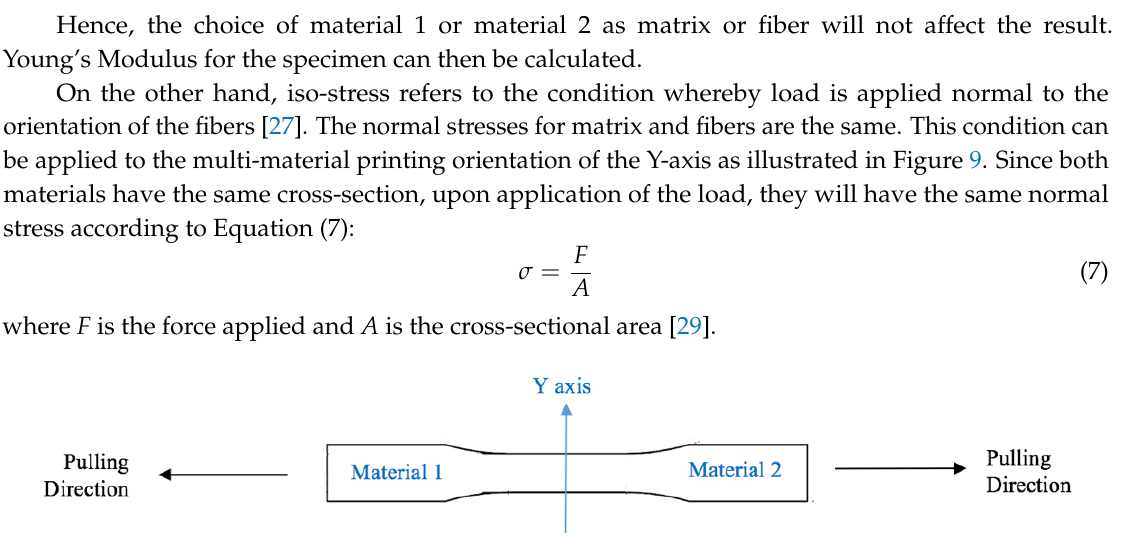
Figure 9. Modelling Y-axis as iso-stress.